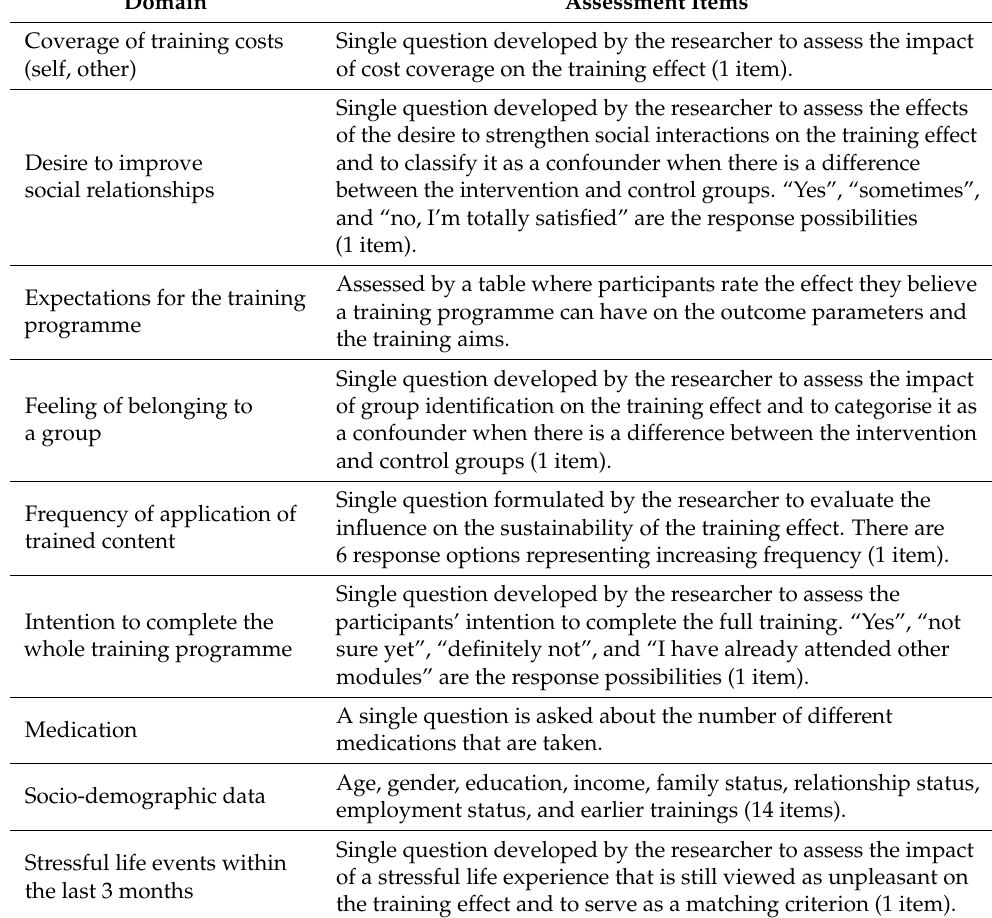
Table 4. Detailed description of the additional assessment